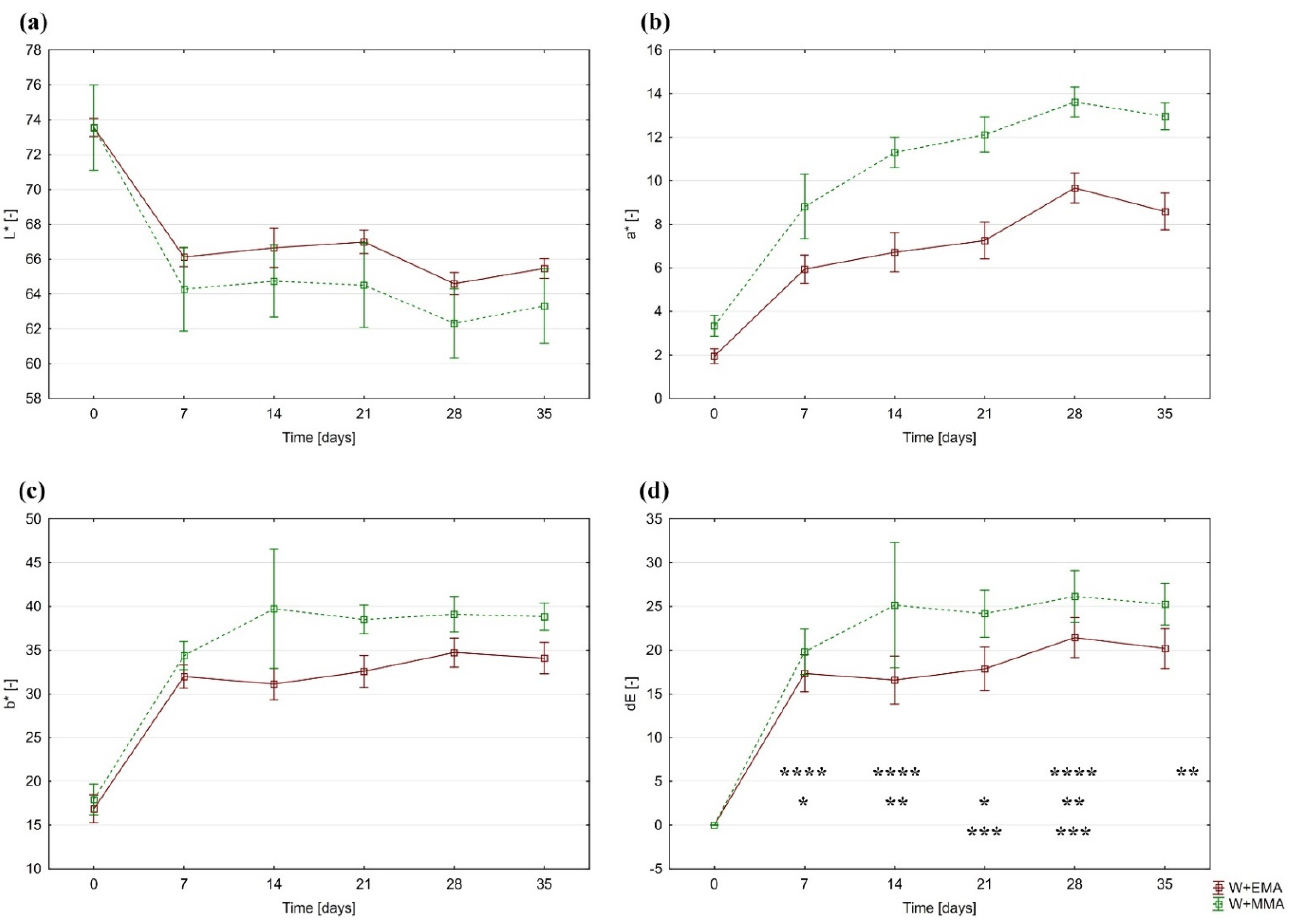
Figure 2. Time dependence of colour components in CIE L*a*b* space and total colour difference: ( a ) Lightness; ( b ) the coordinate a* ; ( c ) b* coordinate; ( d ) total colour difference *, **, *** denoted exposure times of W+EMA and **** denoted exposure times of W+MMA at which the total colour differences were statistically significant based on the results of Duncan’s test (difference between 0 days of exposure and other exposure times is obvious without statistical test).